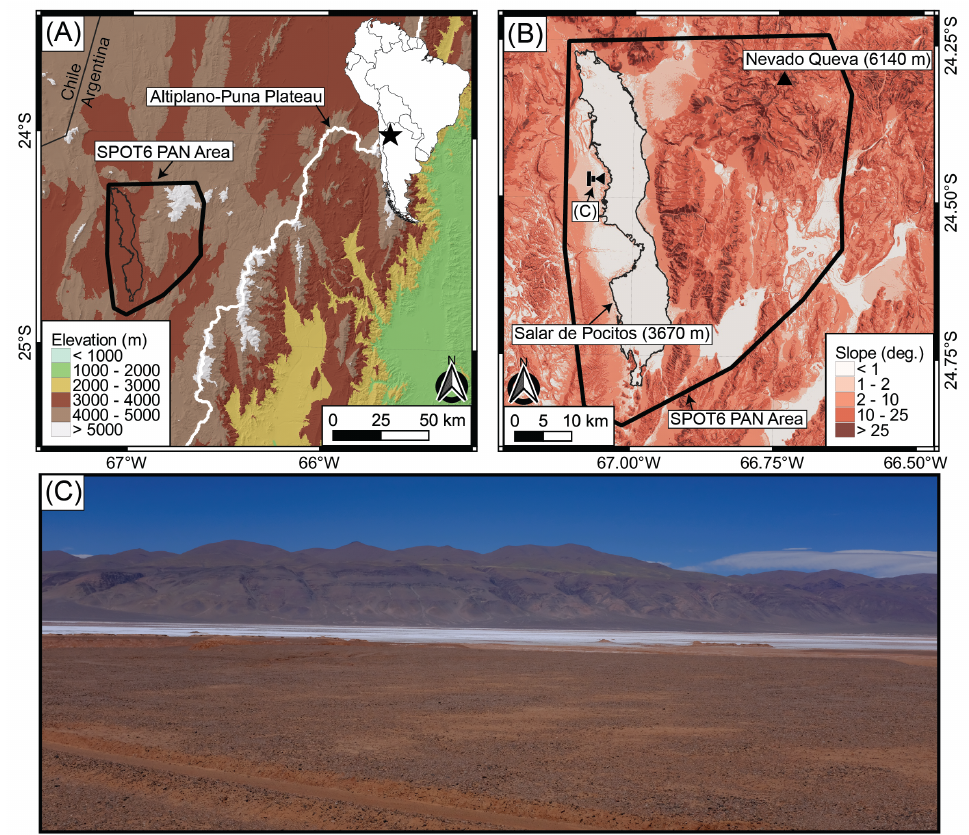
Figure 1. The study area in northwestern Argentina: ( A ) topography from Copernicus 30 m DEM [32]. The eastern area of the map shows steep east-to-west gradients in topography to the drainage boundary of the hyperarid, internally drained Altiplano-Puna Plateau (shown in white), where elevation is ≥ 3000 m. SPOT6 panchromatic (PAN) area shows the stereo–data extent; ( B ) zoom on the SPOT6 data area centered on the Salar de Pocitos dry paleolake bed (salt flat) with steep surrounding mountains and a ∼ 2500 m elevation gradient between the salar (lowest elevation) and highest volcanic mountain (Nevado Queva). Slope map indicating the flat salar and steep mountains is derived from the Copernicus 30 m DEM; ( C ) photograph identified in ( B ), demonstrating the flat salar (photo taken on low–slope alluvial fan, white area in middle ground is salt flat), and the smooth, vegetation–free topography of the surrounding mountains characteristic of the study area, with localized bedrock outcrops and incised